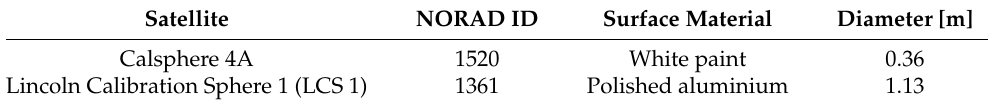
Table 1. Observed radar calibration spheres. Parameters were obtained from